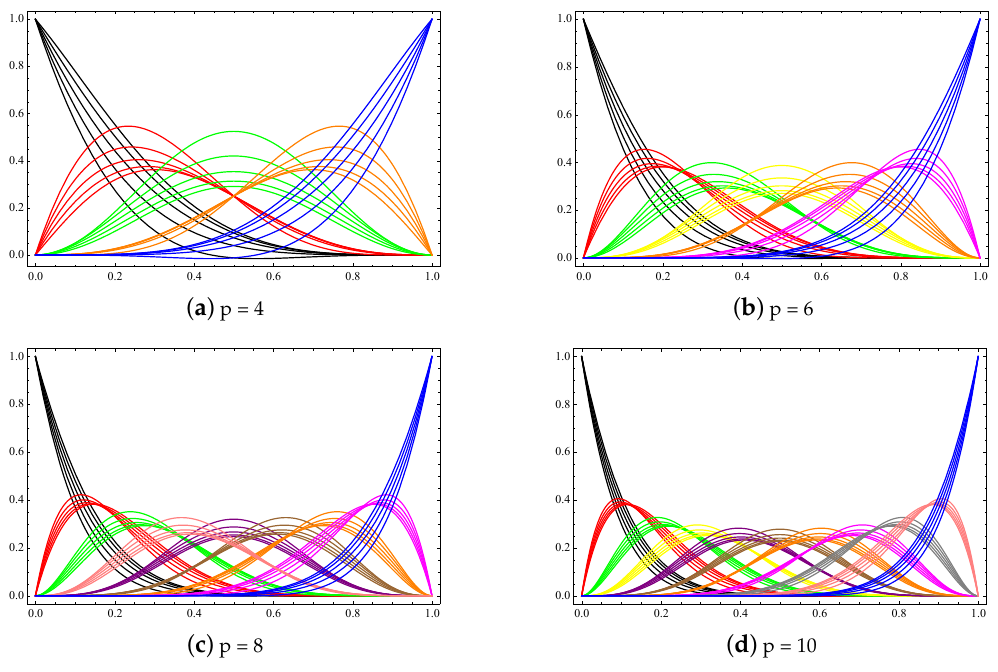
Figure 1. Plots of p degree GHT-Bernstein basis